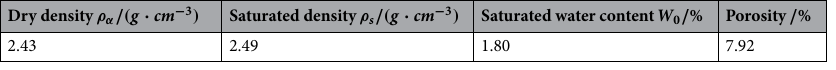
evenly filled with water. The specimens were put into a water tank, first filled with water to 1/4 of the height of the specimens, then filled with water to 1/2 and 3/4 of the height of the specimens every 2 h, and then immersed